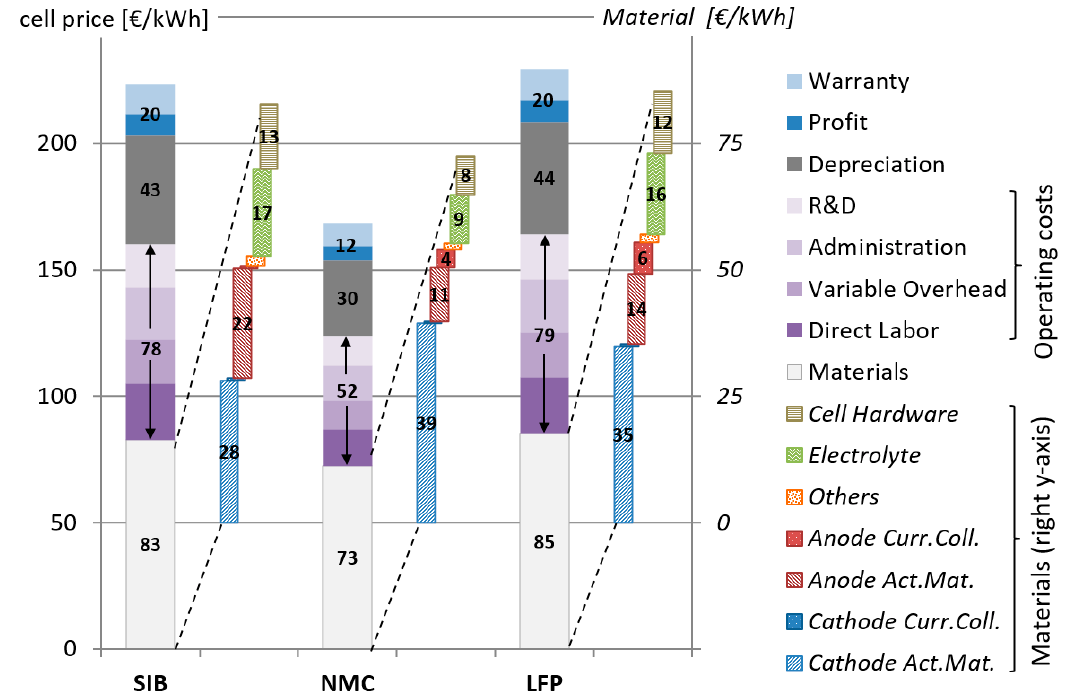
Figure 2. Cell costs per kWh of storage capacity broken down to battery components and battery materials.